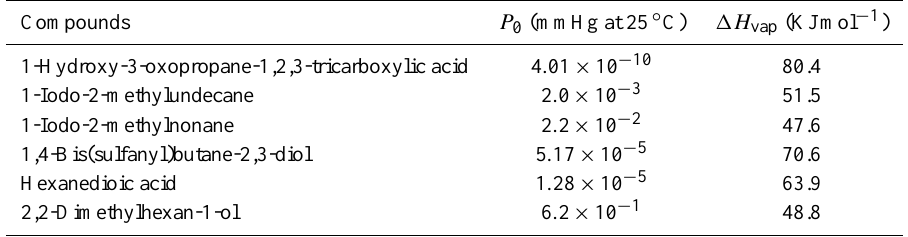
Table 4. Theoretical vapour pressure ( P 0 ) and vaporization enthalpy ( 1H vap ) for the compounds contained in groups 1 and 2.